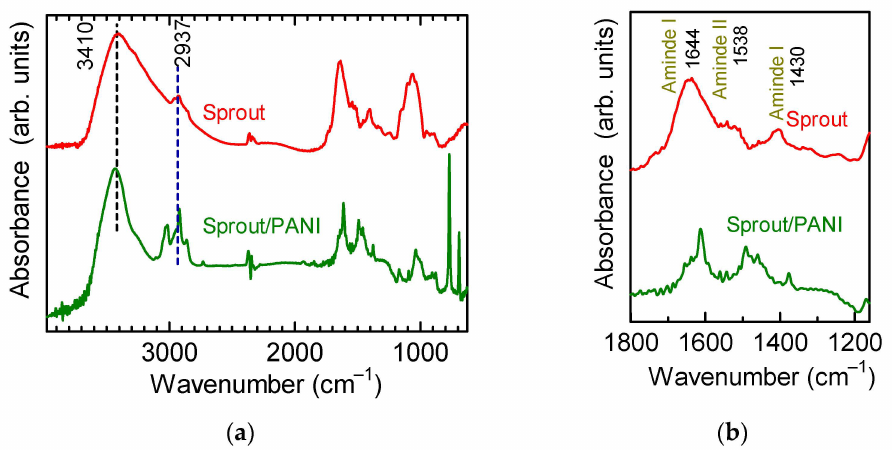
Figure 2. ( a ) Fourier transform infrared (FT-IR) absorption spectra of the pure sprout and sprout/polyaniline (sprout/PANI). ( b ) Magnification of the FT-IR absorption spectra of the sprout and sprout/PANI.